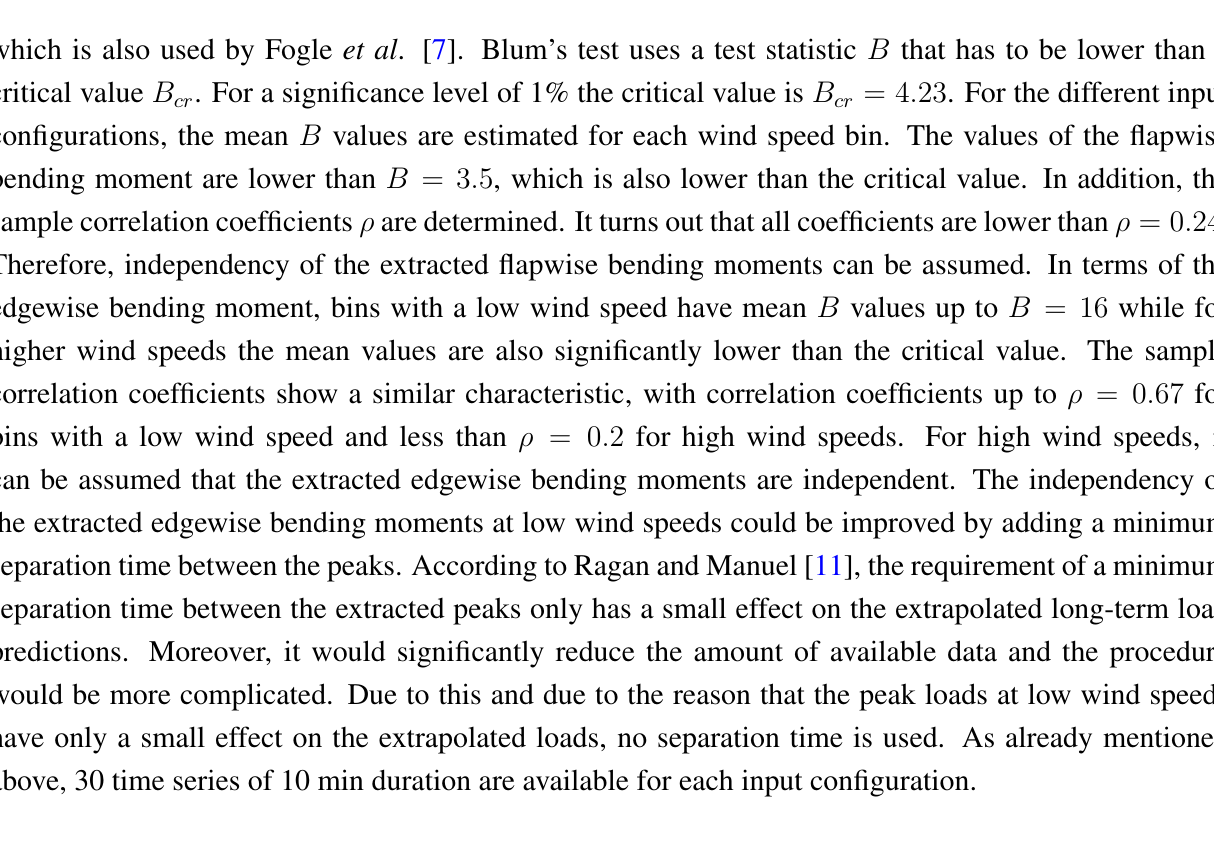
Figure 6. Long-term exceedance probability distribution of the bending moments at the blade root calculated by means of the POT method. ( a ) Flapwise; ( b )